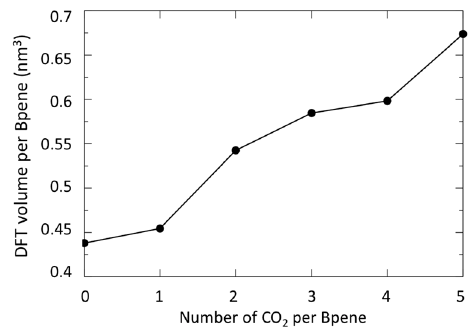
Figure 8. DFT predicted cell volume versus CO 2 loading.